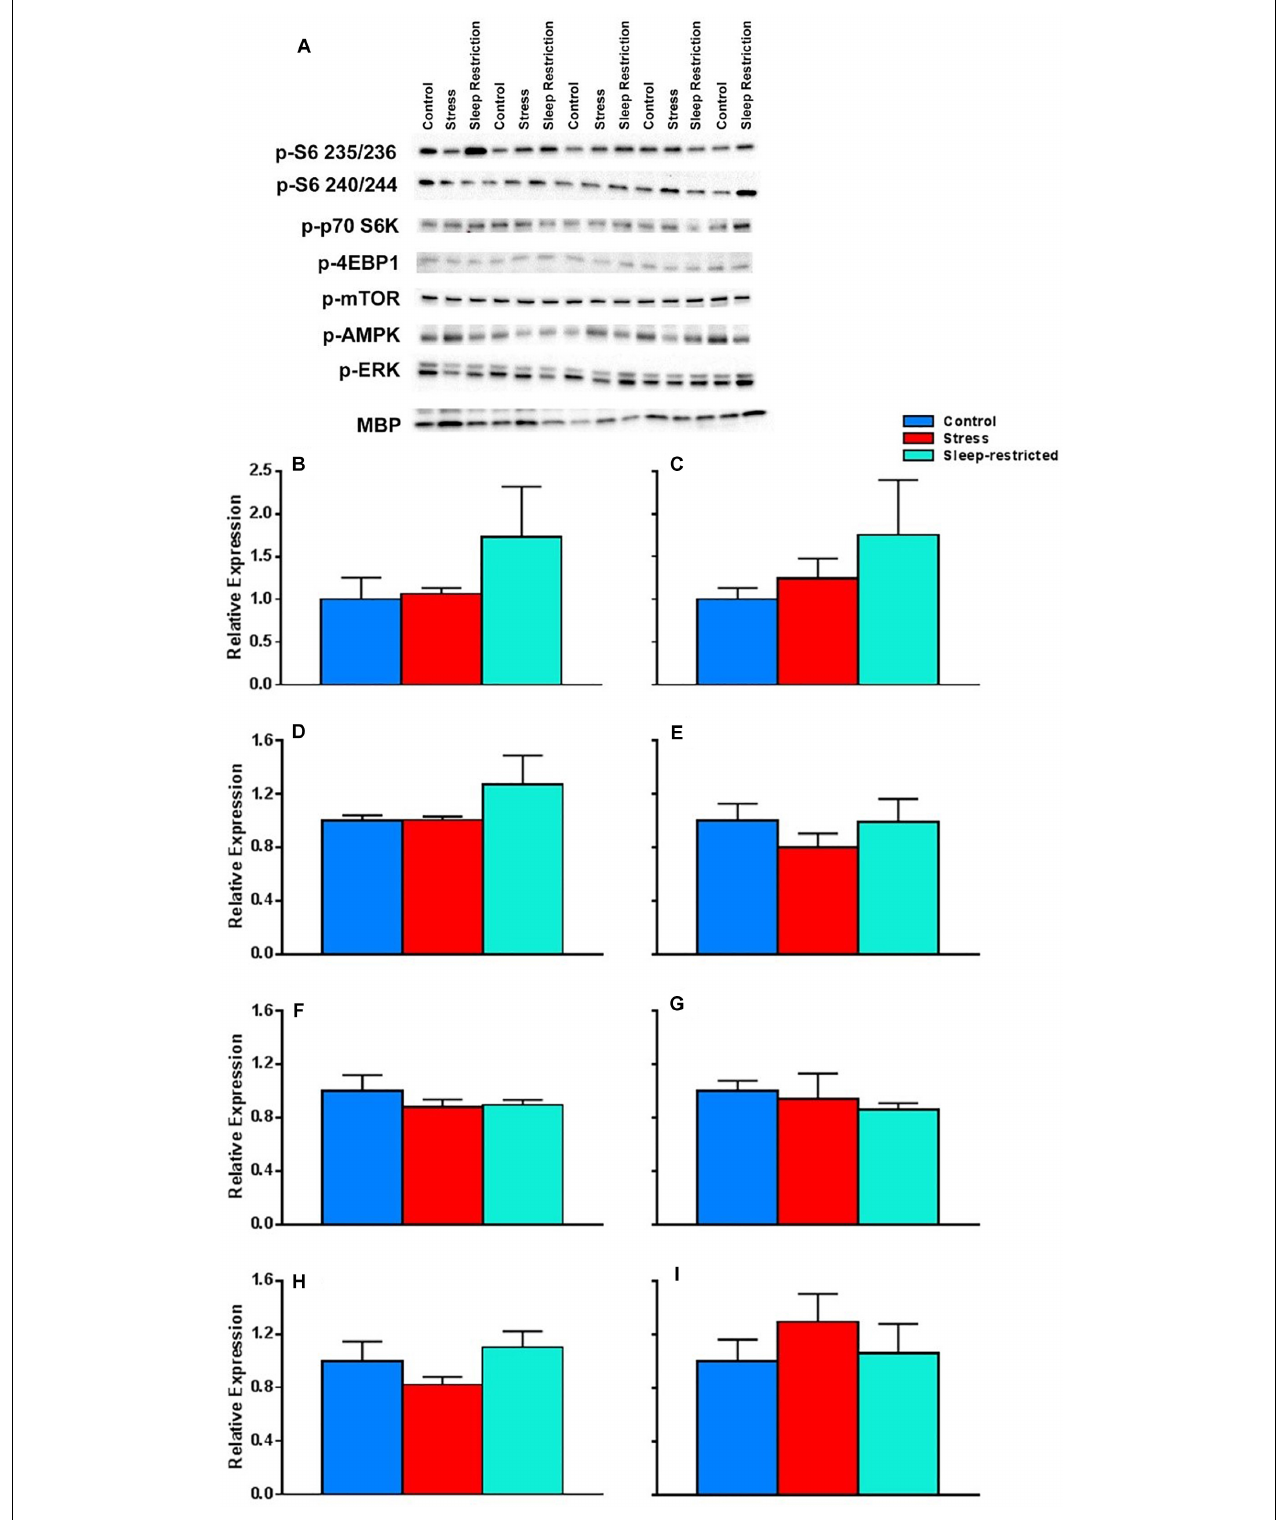
FIGURE 9 | Effects on key proteins at P94. (A) Images of the blots. (B–I) Protein levels were normalized to controls for p-S6 235/236 (B) , p-S6 240/244 (C) , p-p70 S6K (D) , p-4EBP1 (E) , p-mTOR (F) , p-AMPK (G) , p-ERK (H) , and MBP (I) . Each bar represents mean ± SEM for control group ( n = 5), stress group ( n = 4), and sleep-restricted group ( n = 5). Results of ANOVA are presented in Table 3 . We found no statistically significant effects of condition.